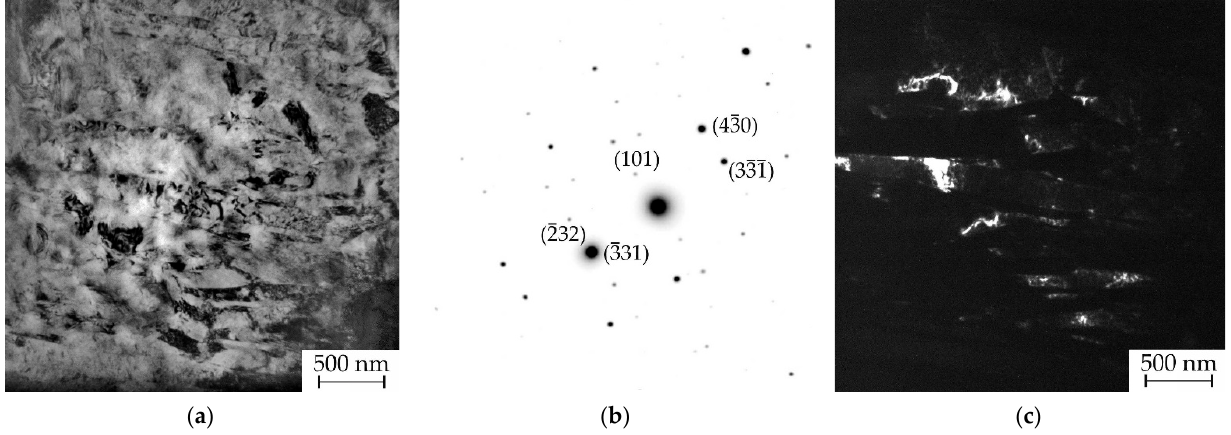
Figure 1. The bright-field microstructure image (TEM) of the initial samples ( a ); the microdiffraction pattern from the central zone of Figure 1a ( b ); the dark-field image, (cid:4666) 43 (cid:3364) 0 (cid:4667) R phase reflection ( c ).